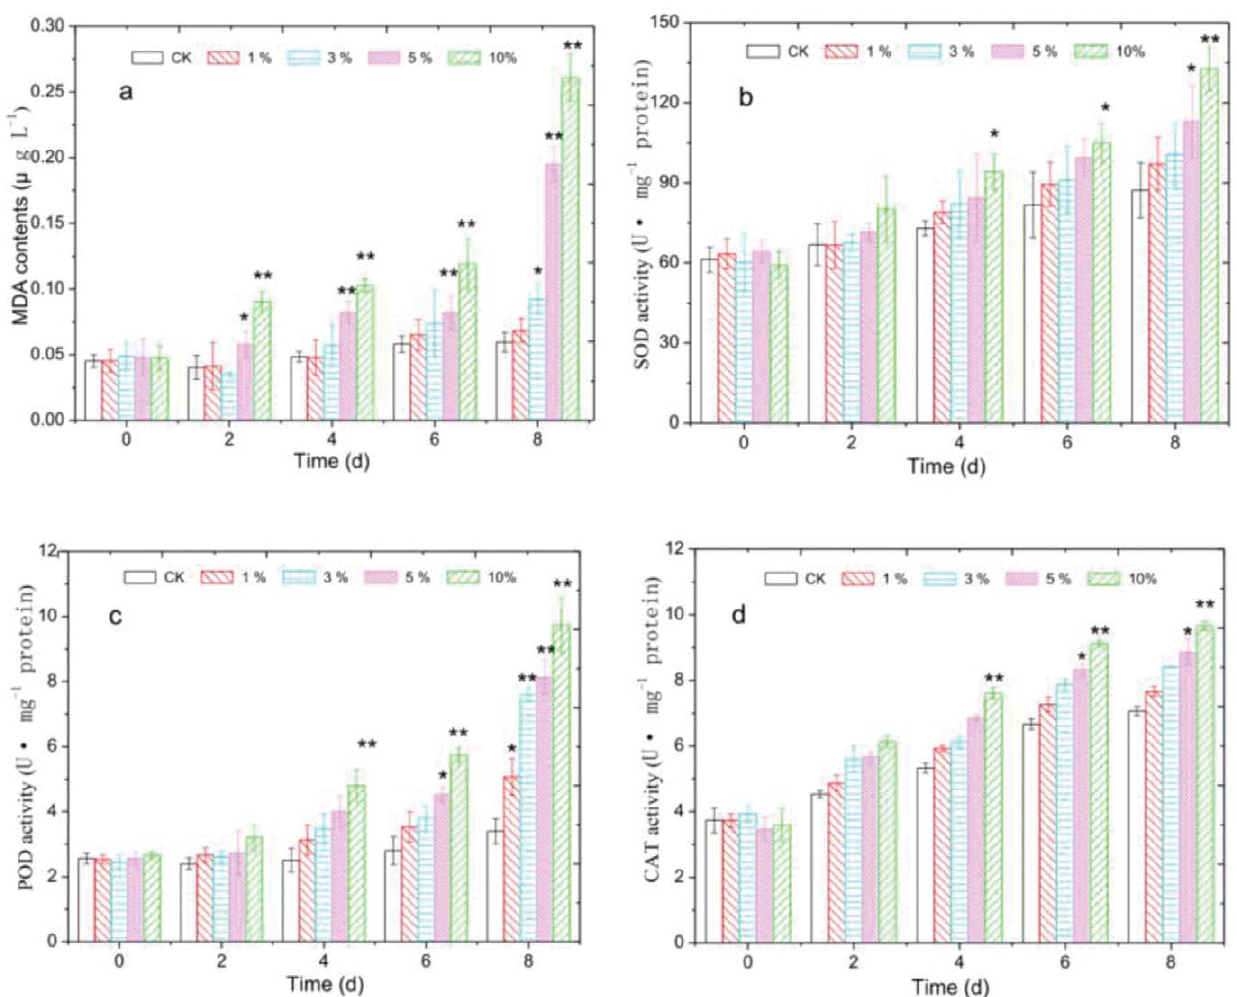
Figure 3. Effect of Streptomyces sp. HJC-D1 culture broth on MDA content and SOD, POD and CAT activities. (a) MDA contents; (b) SOD activities; (c) POD activities; (d) CAT activities. * represents a statistically significant difference of p , 0.05 when compared to the control, ** represents a statistically significant difference of p , 0.01.